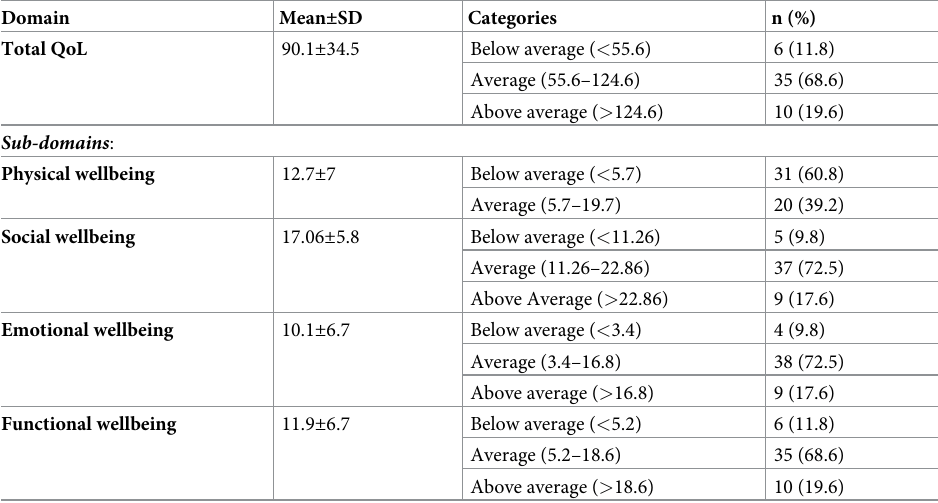
Table 3. Quality of life (QoL) of the respondents and domain-wise distribution (n = 51).